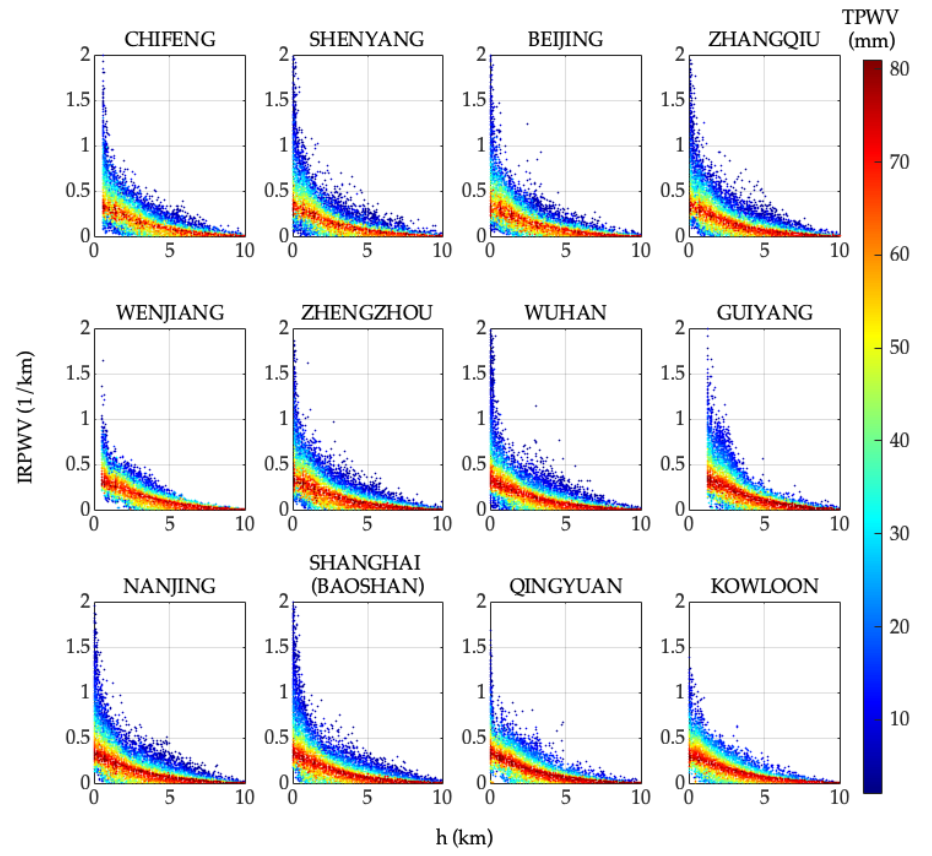
Figure 2. The vertical distribution of IRPWV in the 10-year period from 2008 to 2017 over each of the 12 stations. The color bar indicates the value of TPWV (in mm).